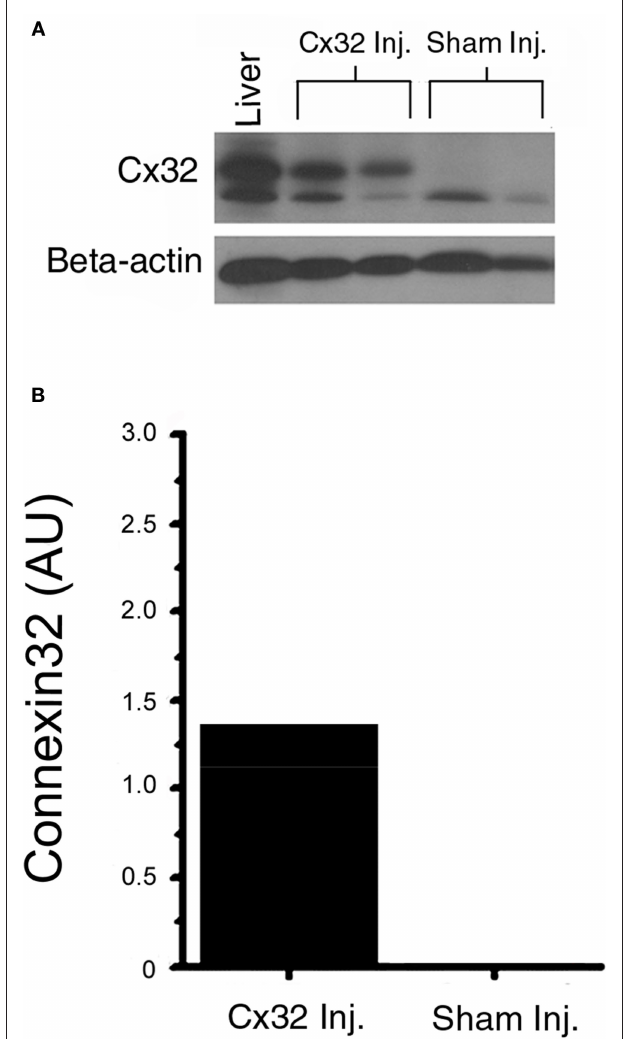
Figure 1 | (A) Western blot analysis of Cx32 protein. Lysates of mouse ventricles from wild-type and Cx32 adenoviral vector-injected wild-type mice were run on 4–20% Tris–glycine gradient gels using mouse liver as a positive control for Cx32. (B) The data confirm the presence of Cx32 in injected wild type ventricles (Cx32 Inj), and the absence of Cx32 in the sham-injected ventricles (Sham